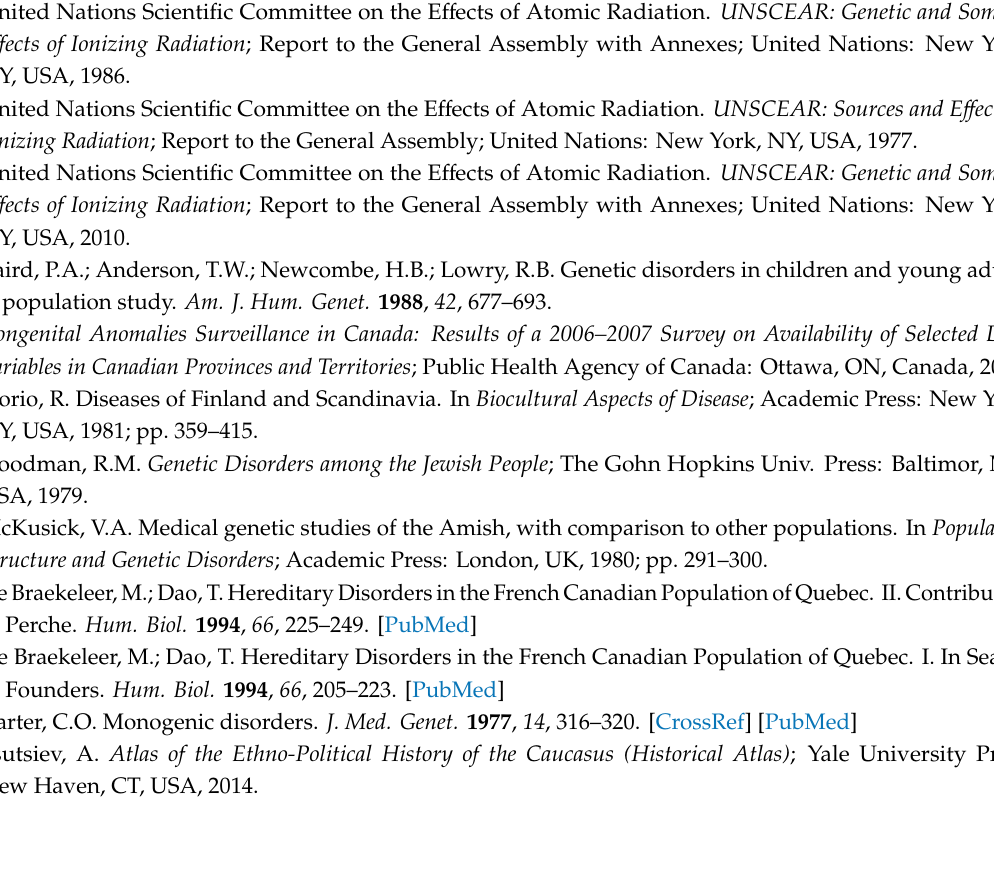
s1. Table S1. Nosological spectrum and prevalence (per 100,000) of hereditary neurological diseases in Karachay-Cherkess Republic (KChR). Table S2. Nosological spectrum and prevalence (per 100,000) of hereditary ophthalmic diseases in Karachay-Cherkess Republic. Table S3. Nosological spectrum and prevalence (per 100,000) of hereditary genodermatoses diseases in Karachay-Cherkess Republic. Table S4. Nosological spectrum and prevalence (per 100,000) of hereditary skeletal diseases in Karachay-Cherkess Republic. Table S5. Nosological spectrum and prevalence (per 100,000) of hereditary syndromes in Karachay-Cherkess Republic. Table S6. Nosological spectrum and prevalence (per 100,000) of other hereditary diseases in Karachay-Cherkess